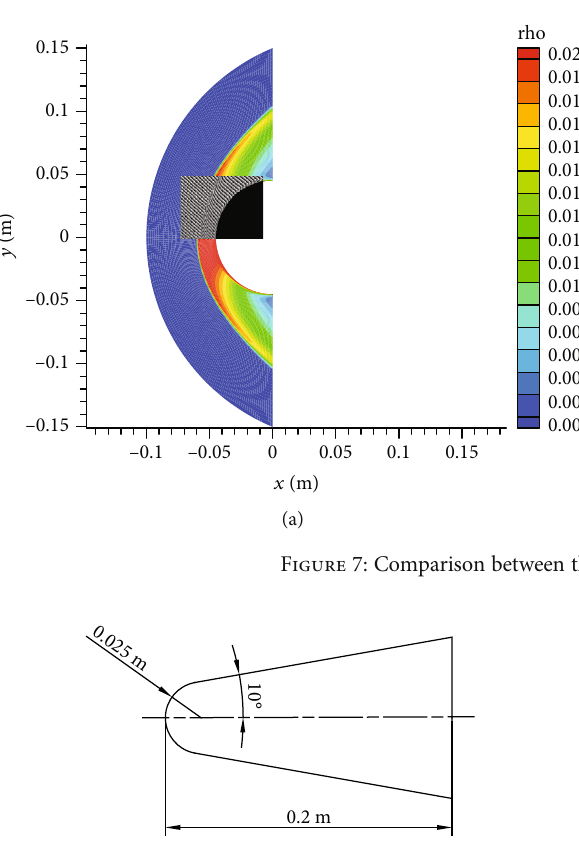
Figure 8: Geometry of the leading edge.